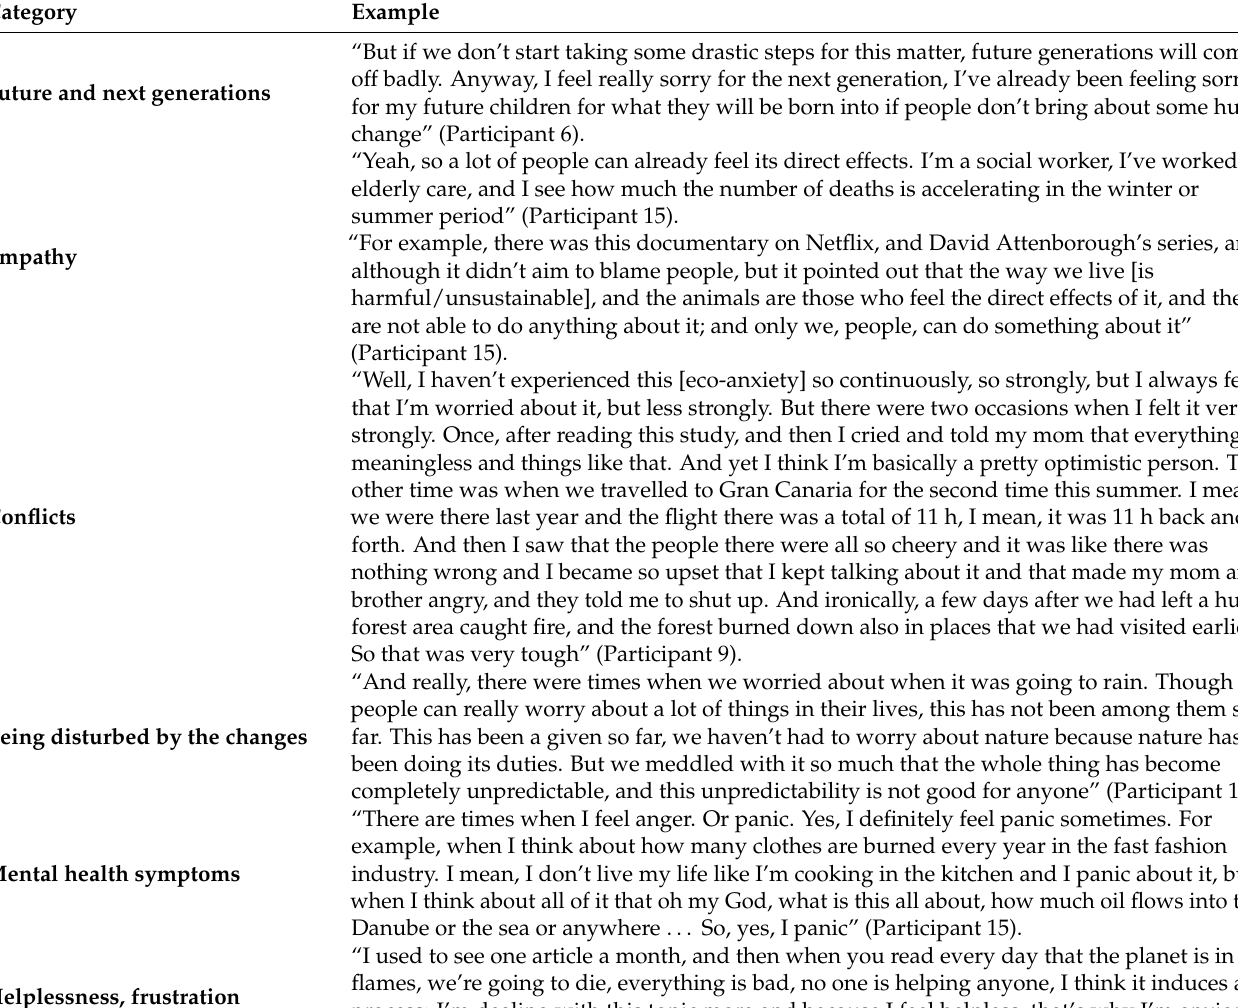
Table 2. Aspects of